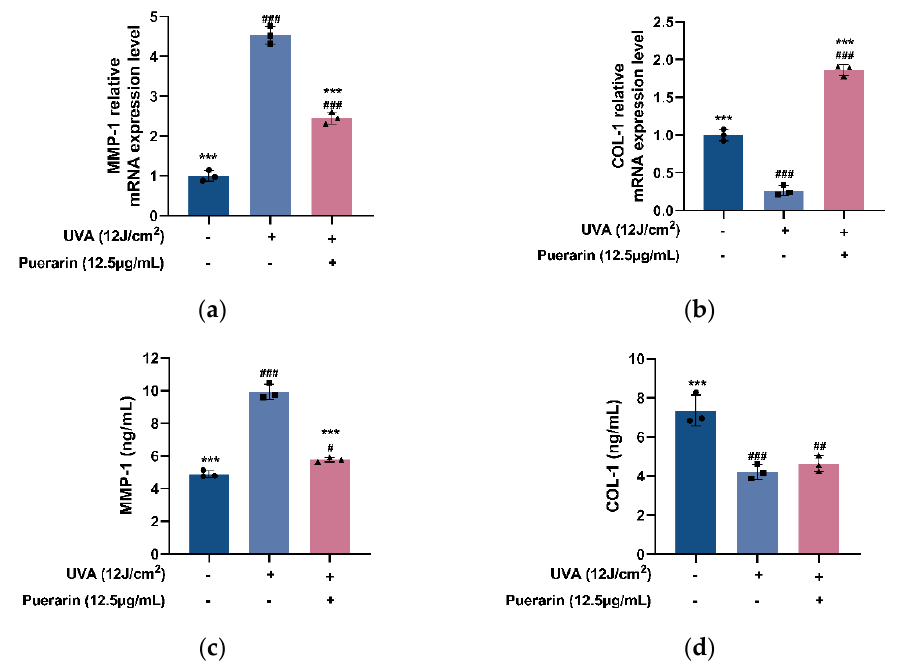
Figure 6. Effects of puerarin on UVA ‐ induced skin aging markers in HSF: ( a , b ) Effects of puerarin on MMP ‐ 1 and COL ‐ 1 expression of HSF with UVA ‐ induced oxidative damage; ( c , d ) Effects of puerarin on MMP ‐ 1 and COL ‐ 1 content of HSF with UVA ‐ induced oxidative damage. # p < 0.0 5 , ## p < 0.0 1 , ### p < 0.001 as compared to the control group; *** p < 0.001 as compared to the damage model group; Values do not have a common mark ( # , *) when p > 0.05, ( n = 3).